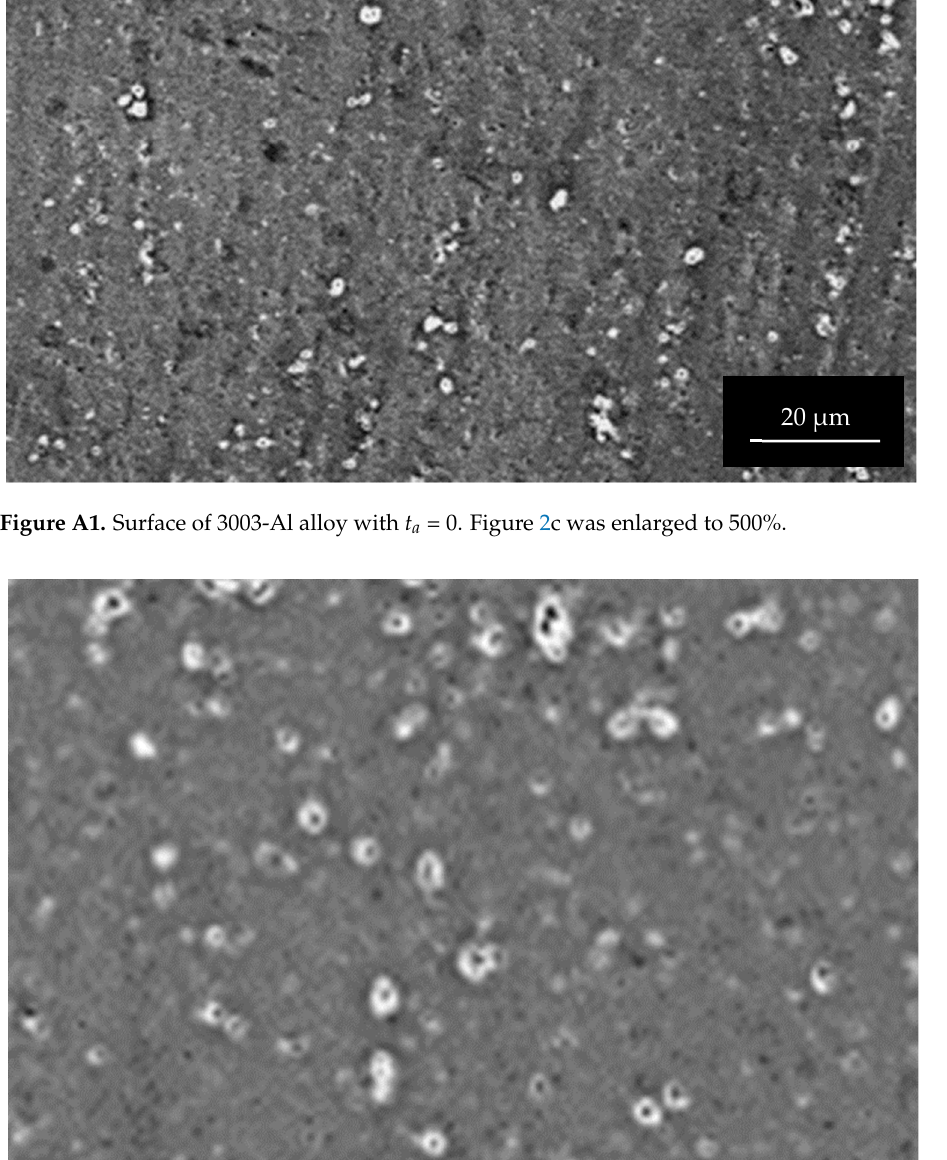
Figure A2. Surface of 3003-Al alloy with t a = 1800 s. Figure 4c was enlarged to 500%.